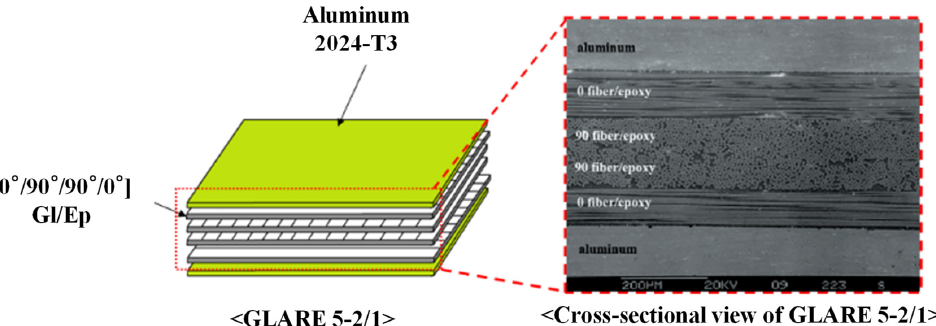
Figure 1. Configuration of GLARE 5-2/1 in